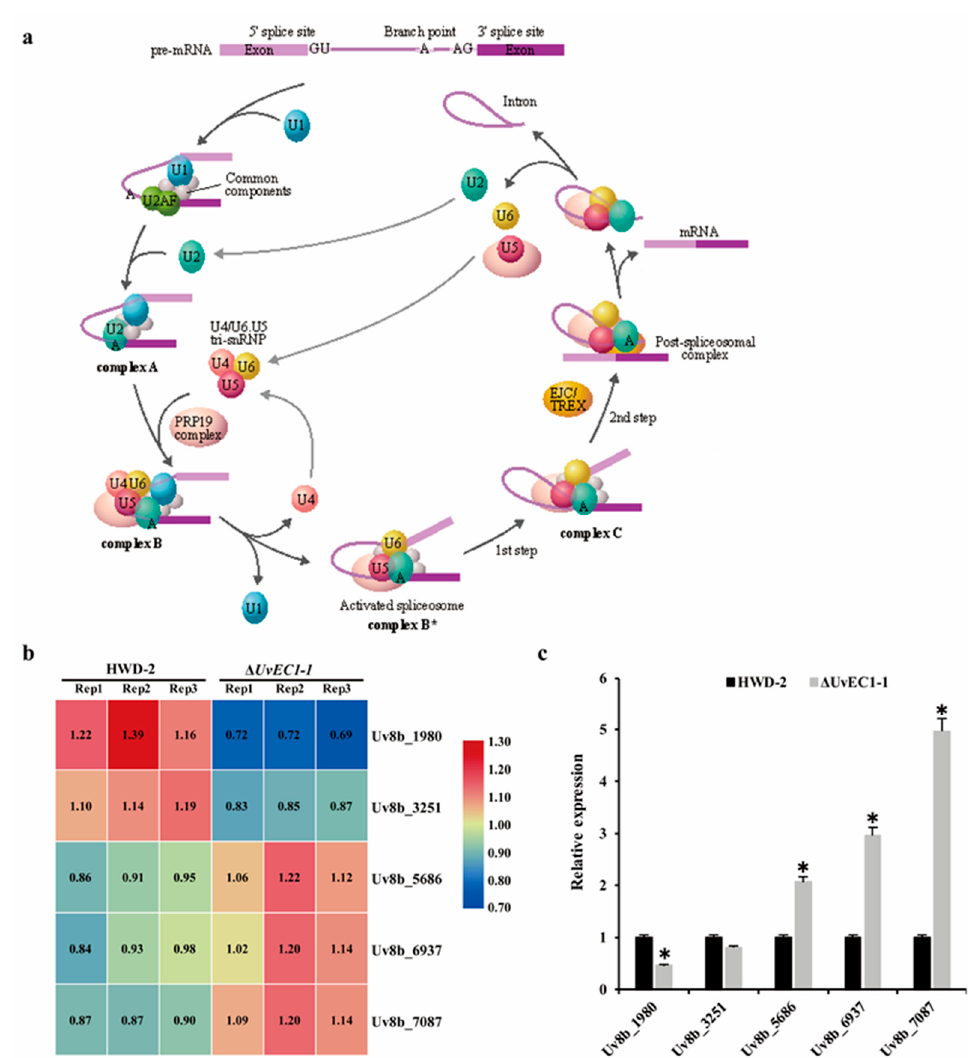
Figure 8. Deletion of UvEC1 affects protein abundance and expression of spliceosome components. ( a ) Spliceosome pathway in U. virens . ( b ) Heatmap analysis of spliceosome protein levels in ∆ UvEC1-1 mutant and wild type HWD-2. ( c ) Relative expression of spliceosome genes in the ∆ UvEC1-1 mutant and wild type HWD-2 by RT-qPCR. Asterisks represent significant differences relative to HWD-2, as determined by LSD at p =